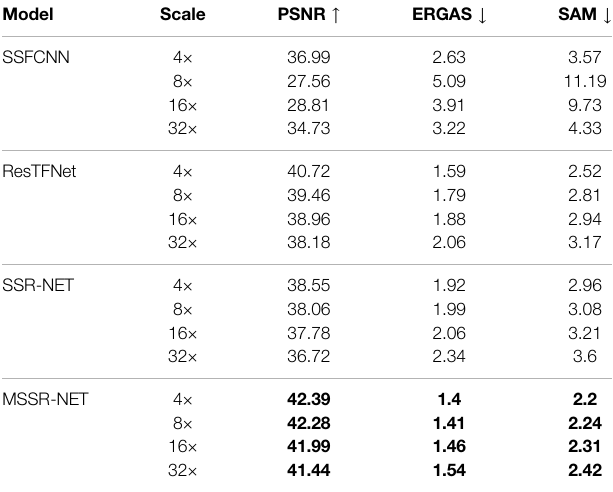
TABLE 6 | Quantitative results on Urban dataset. HR MSI is generated according to Type 1 model. Model Scale